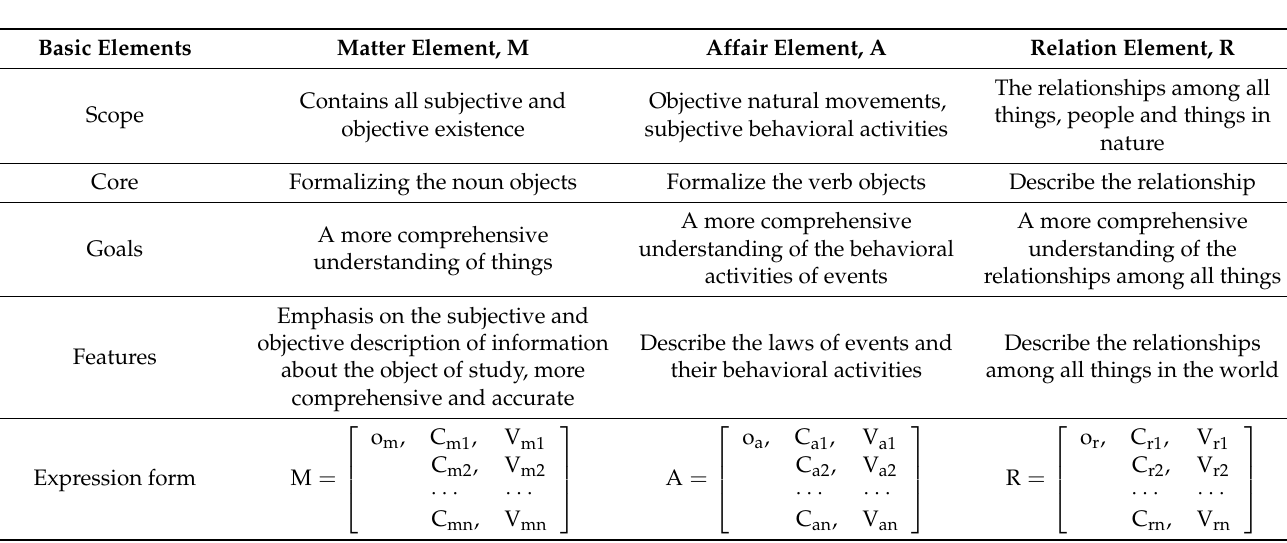
Table 1. The three basic